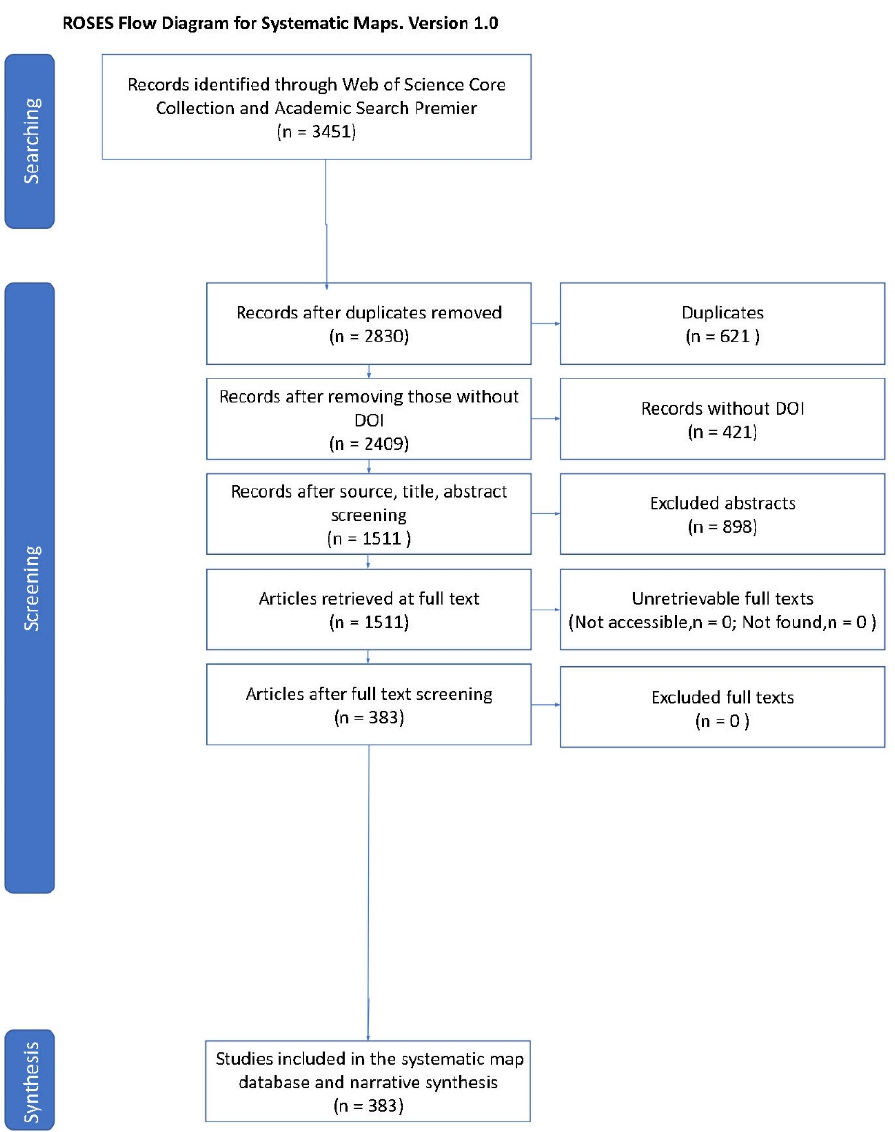
Figure 1. Search and review ROSES flow diagram for a systematic map of human–raptor interaction and coexistence research.